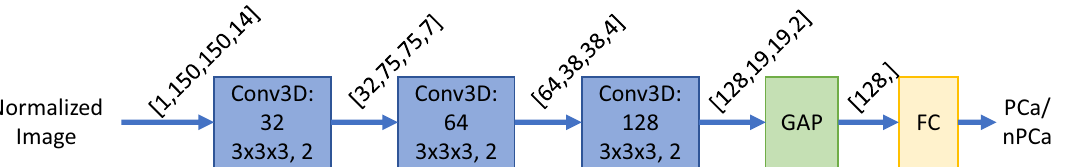
Figure 2. The 3D convolutional neural network pipeline used for classification. The input is a pre-processed CT scan of 150 × 150 × 14 voxels, and the output is a single probability (from 0 to 1) of having